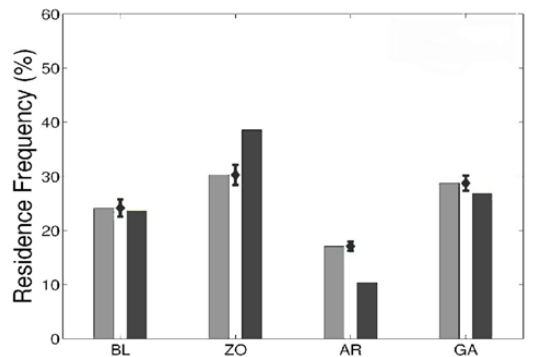
Fig. 6. Estimates of the changes in the frequencies of the LAR obtained from climate simulations. The bars, representing the fre- quencies of each of the four LAR types, are shaded light for the historical simulations and dark for the scenario ones. Confidence intervals obtained with a Monte Carlo procedure are depicted near the bars of the historical simulations.